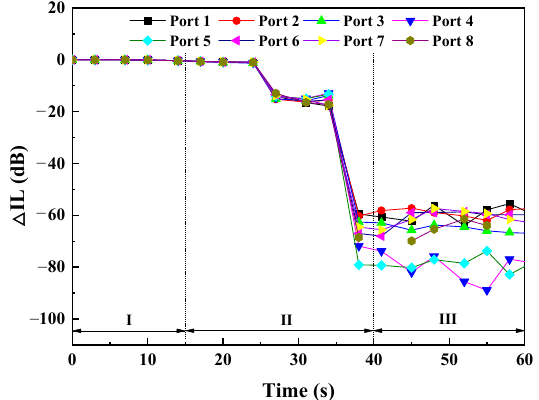
Figure 5. Typical ∆ IL-time curves at 1.55 µ m wavelength for eight output ports in a 1 × 8 PLC optical splitter module in displacement control mode.